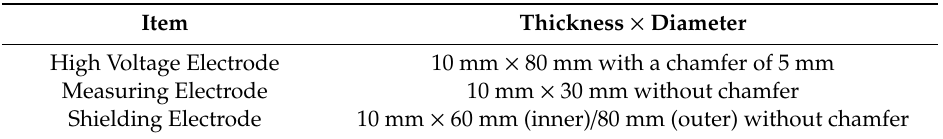
Figure 3. Schematic diagram of the three-electrode experimental chamber: (1) Spherical electrode; (2) current-limiting resistance; (3) bushing; (4) metal shell; (5) polytetrafluoroethylene (PTFE); (6) high voltage electrode; (7) pressboard sample; (8) measuring electrode; (9) shielding electrode; (10) spring; (11) epoxy pillar; (12) flange with through hole. Table 2. Sizes of the three electrodes.